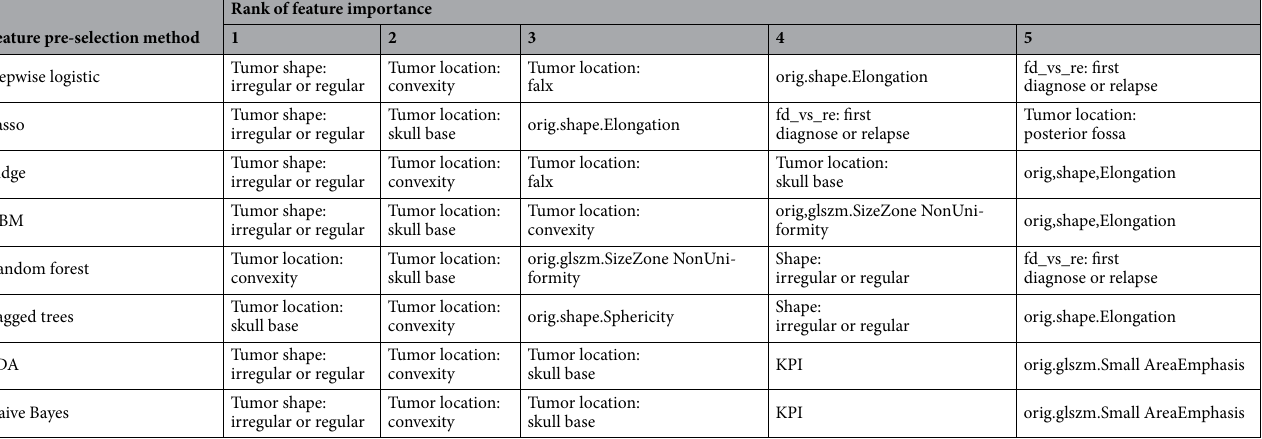
Table 2. Most important five features for each of the eight feature preselection methods.